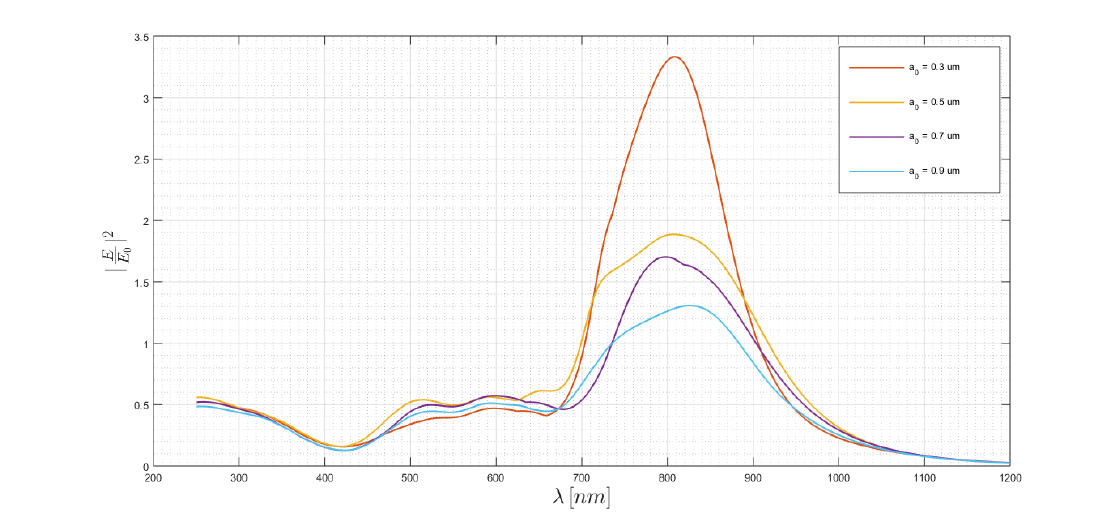
Figure 3. Periodicity sweep on the silver nanostructure.